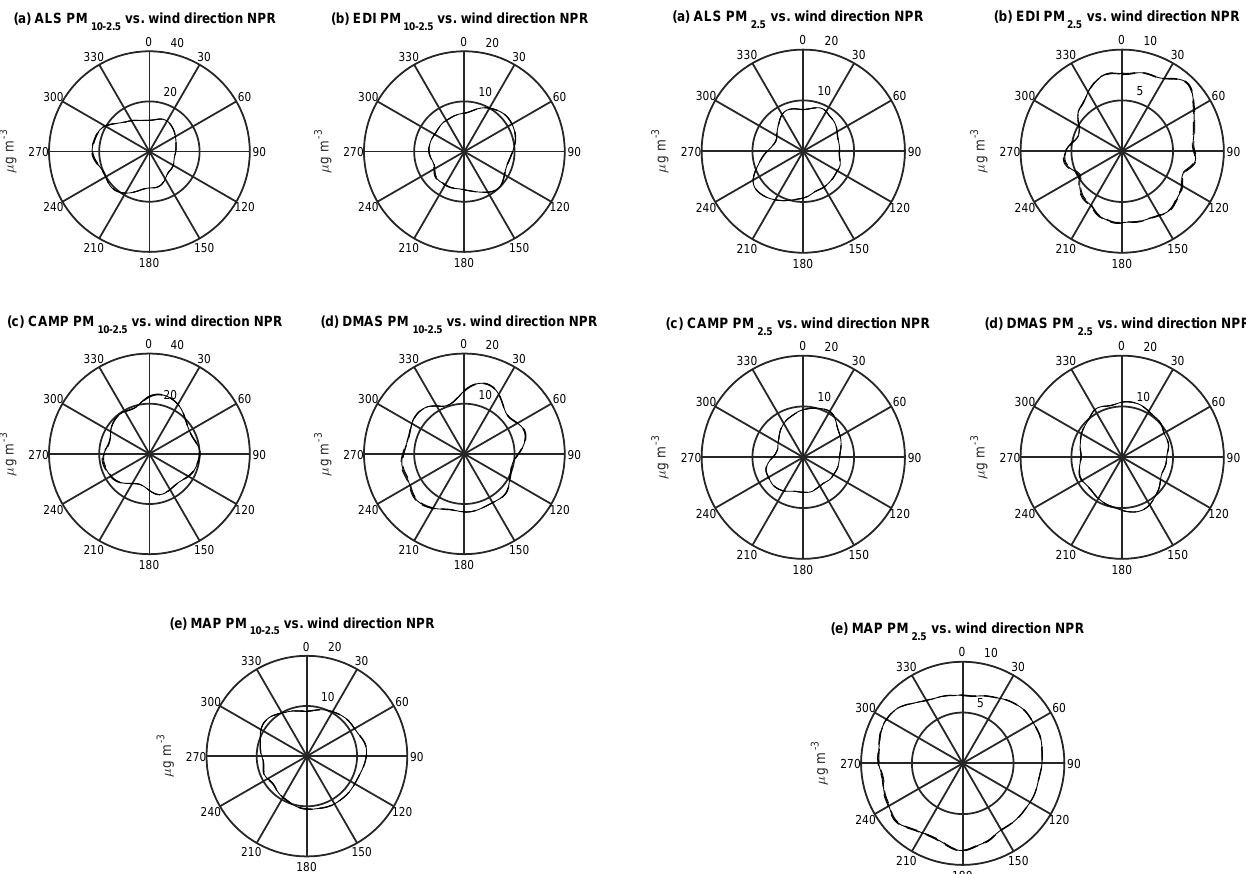
Figure 4. Expected value of PM 10 − 2 . 5 concentrations (dashed lines are 95% confidence intervals) based on nonparametric regression (NPR) against wind direction for (a) ALS, (b) EDI, (c) CAMP, (d) DMAS, and (e) MAP.